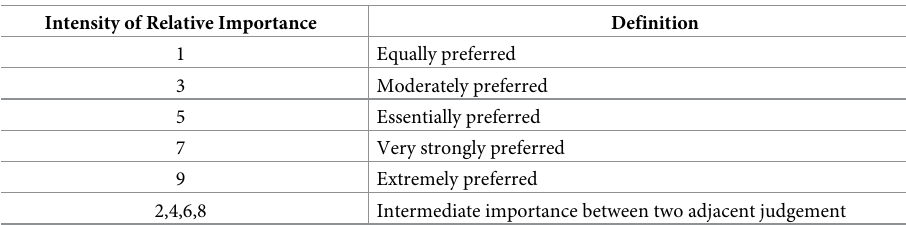
Table 2. Saaty’s nine-point scale